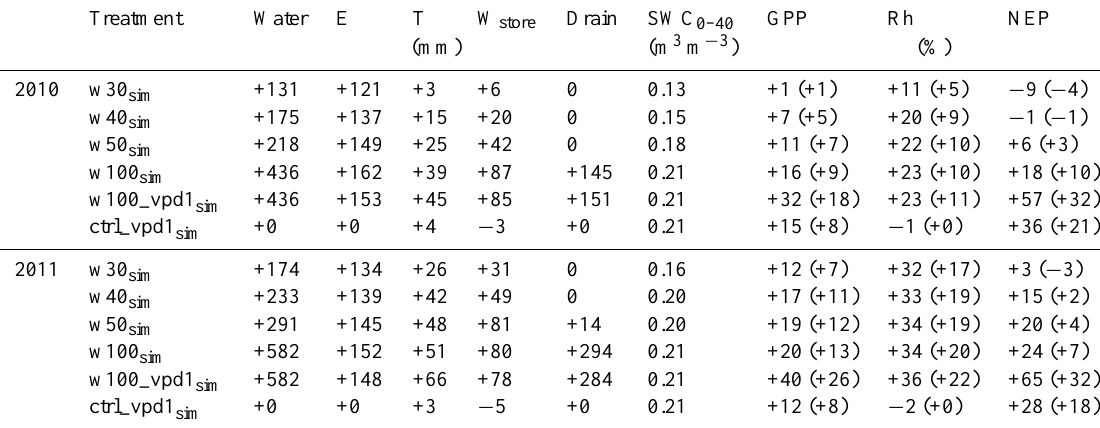
Table 4. Effects of decreased drought compared to “normal” summer conditions derived from simulations with the SPA model. Shown are seasonal changes (June–September) in soil evaporation (E), transpiration (T), soil water storage (2m soil depth) and drainage, as well as mean soil water content (0–40 cm soil depth). Seasonal treatment effects for gross primary productivity (GPP), net ecosystem productivity (NEP) and heterotrophic respiration (Rh) are given. The annual treatment effects are given in brackets. The water addition treatments are shown in percent of water supplied to the irrigation experiment (w100 obs ). The effects of reduced VPD are given for non-drought (w100_vpd1 sim ) and normal summer drought conditions (ctrl_vpd1 sim ).